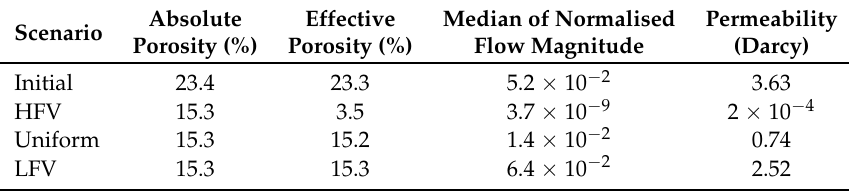
Figure 7. ( a ) Spatial alteration patterns at porosities of 15.3% and 8% for the preferential precipitation at high flow velocity magnitudes (HFV, red), low flow velocity magnitudes (LFV, blue) and uniform alterations, independent of fluid flow (black). ( b ) Permeability calculations of the unaffected microstructure are in good agreement with published laboratory data [22,46,77]. Permeability reduction depends on the spatial precipitation pattern and varies by up to four orders in magnitude (grey filled). Table 3. Hydraulic properties of the initial pore space compared to the microstructures altered by the three spatial precipitation patterns (HFV, uniform and